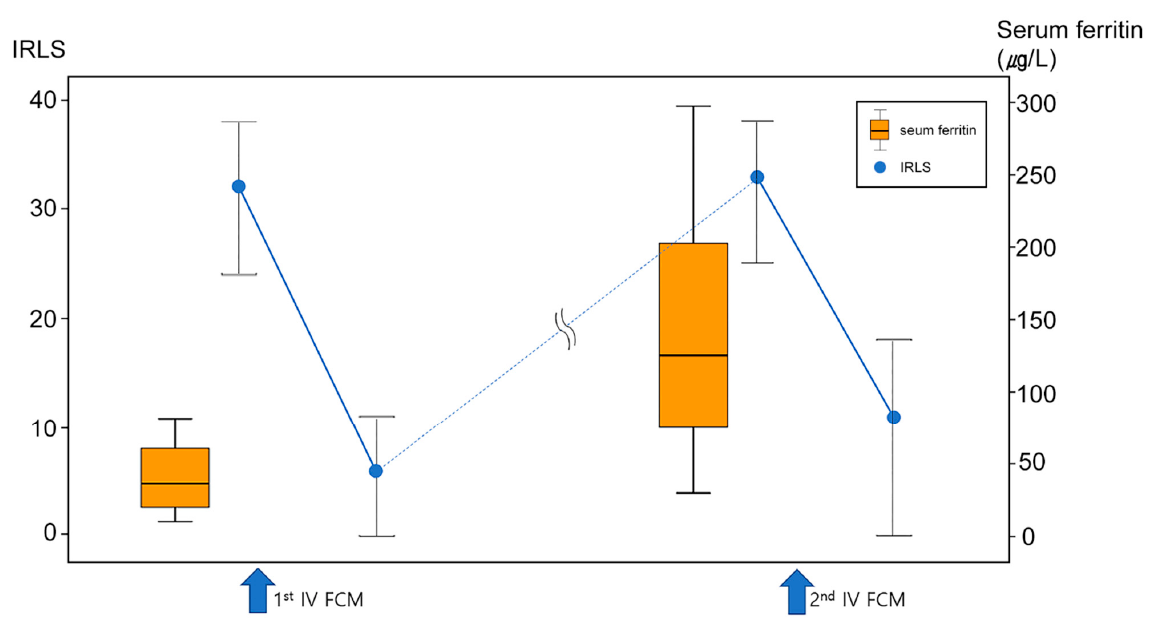
Figure 2. Changes in serum ferritin (orange box plot) and RLS symptoms (IRLS, blue dots) during repeated treatment of IV FCM in primary RLS group. Although IRLS completely returned to baseline (i.e., complete relapse) before second IV FCM, serum ferritin was at a higher level before a second treatment compared to baseline.